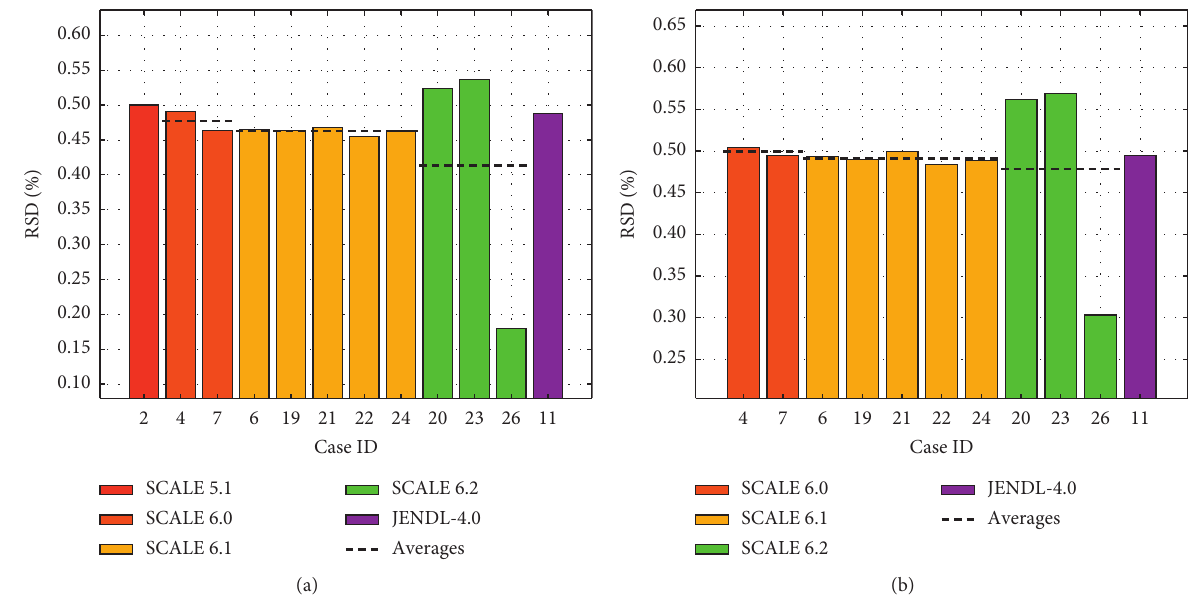
Figure 7: RSD of predicted k -inf at HZP under (a) unrodded and (b) rodded